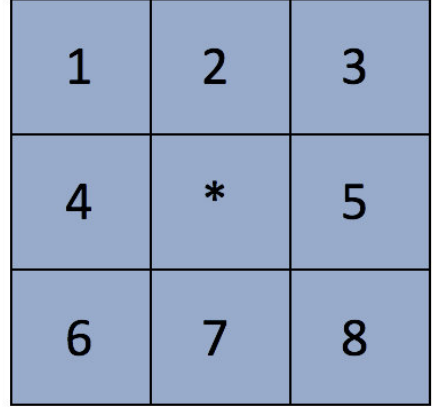
Figure 6. Moore neighborhood (R =